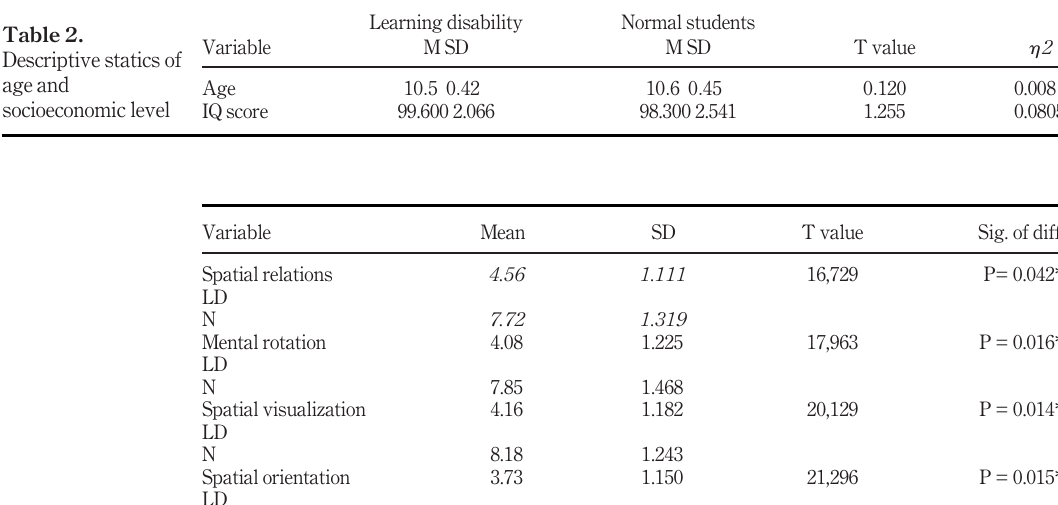
Table 3. Differences between math learning disability and normal students in spatial ability